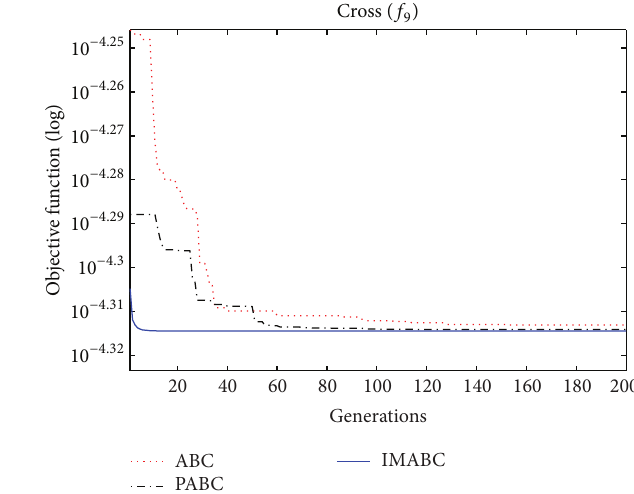
Figure 9: 𝑓 7 function convergence performance comparison.